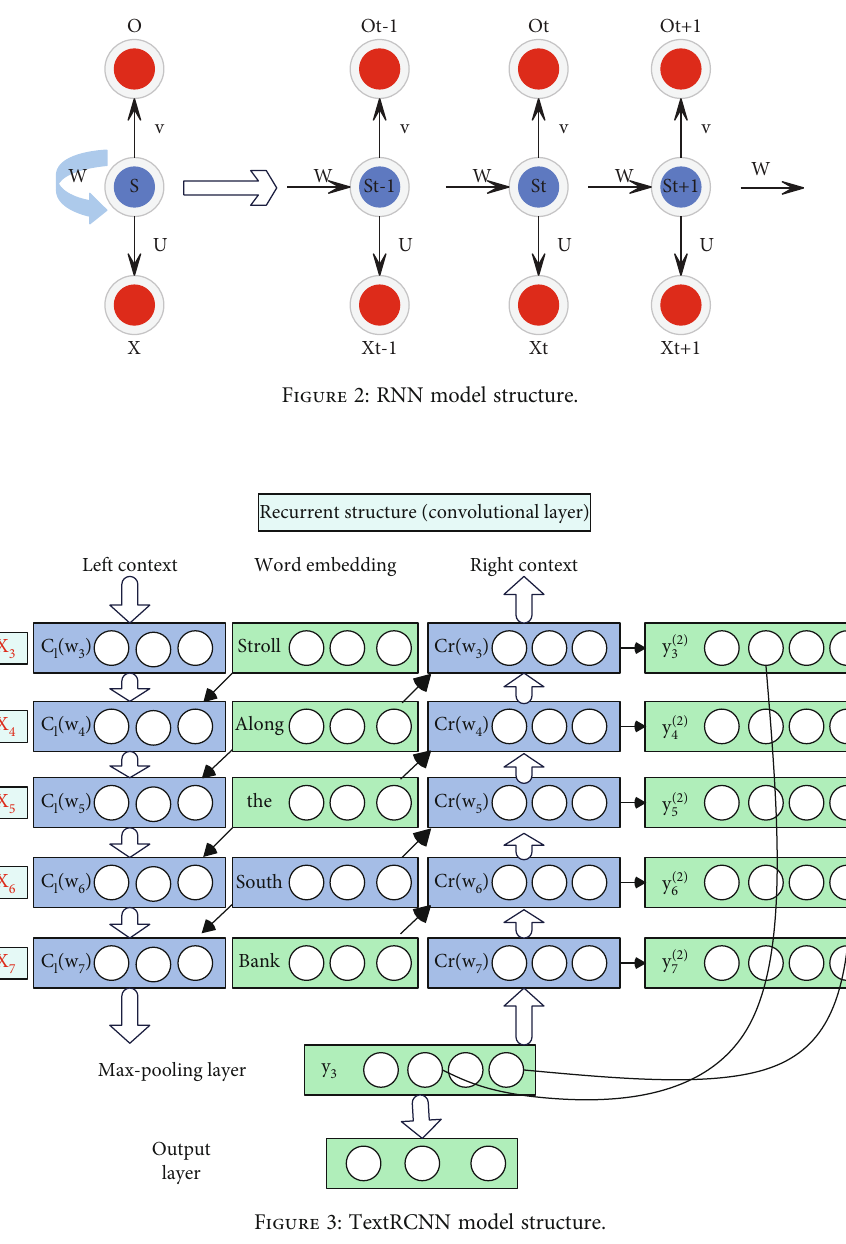
Figure 3: TextRCNN model structure.